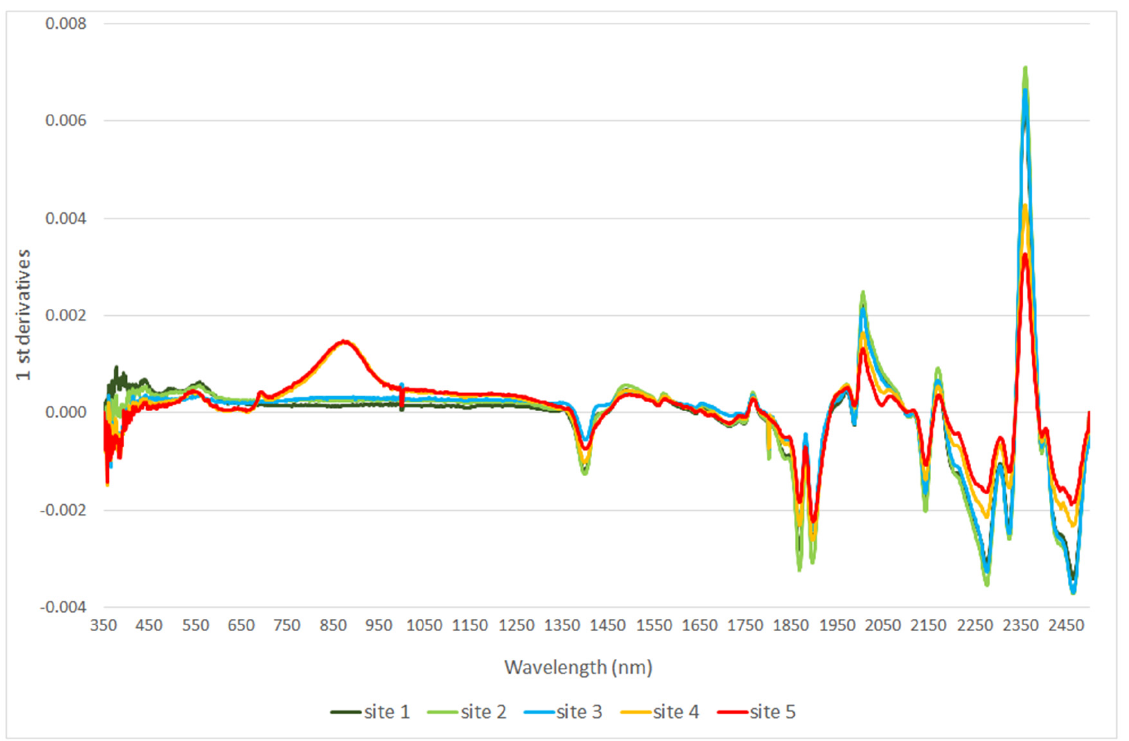
Minerals 2023 , 13 , x FOR PEER REVIEW Figure 6. First derivative of spectral characteristics for the Hallstä tt er Glacier foreland test sites. Figure 6. First derivative of spectral characteristics for the Hallstätter Glacier foreland test sites.